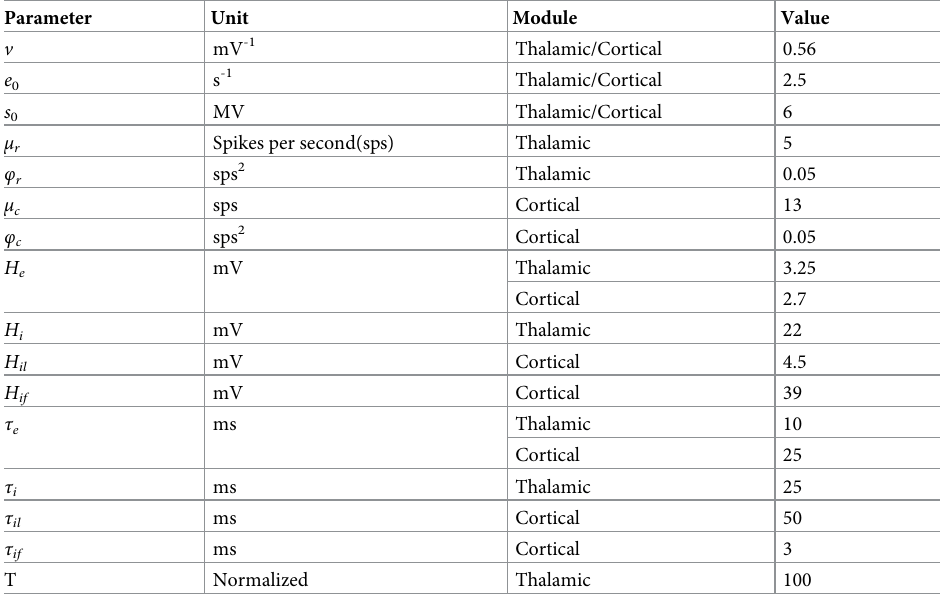
Table 2. Values of other parameters in this model that sourced from works [41,